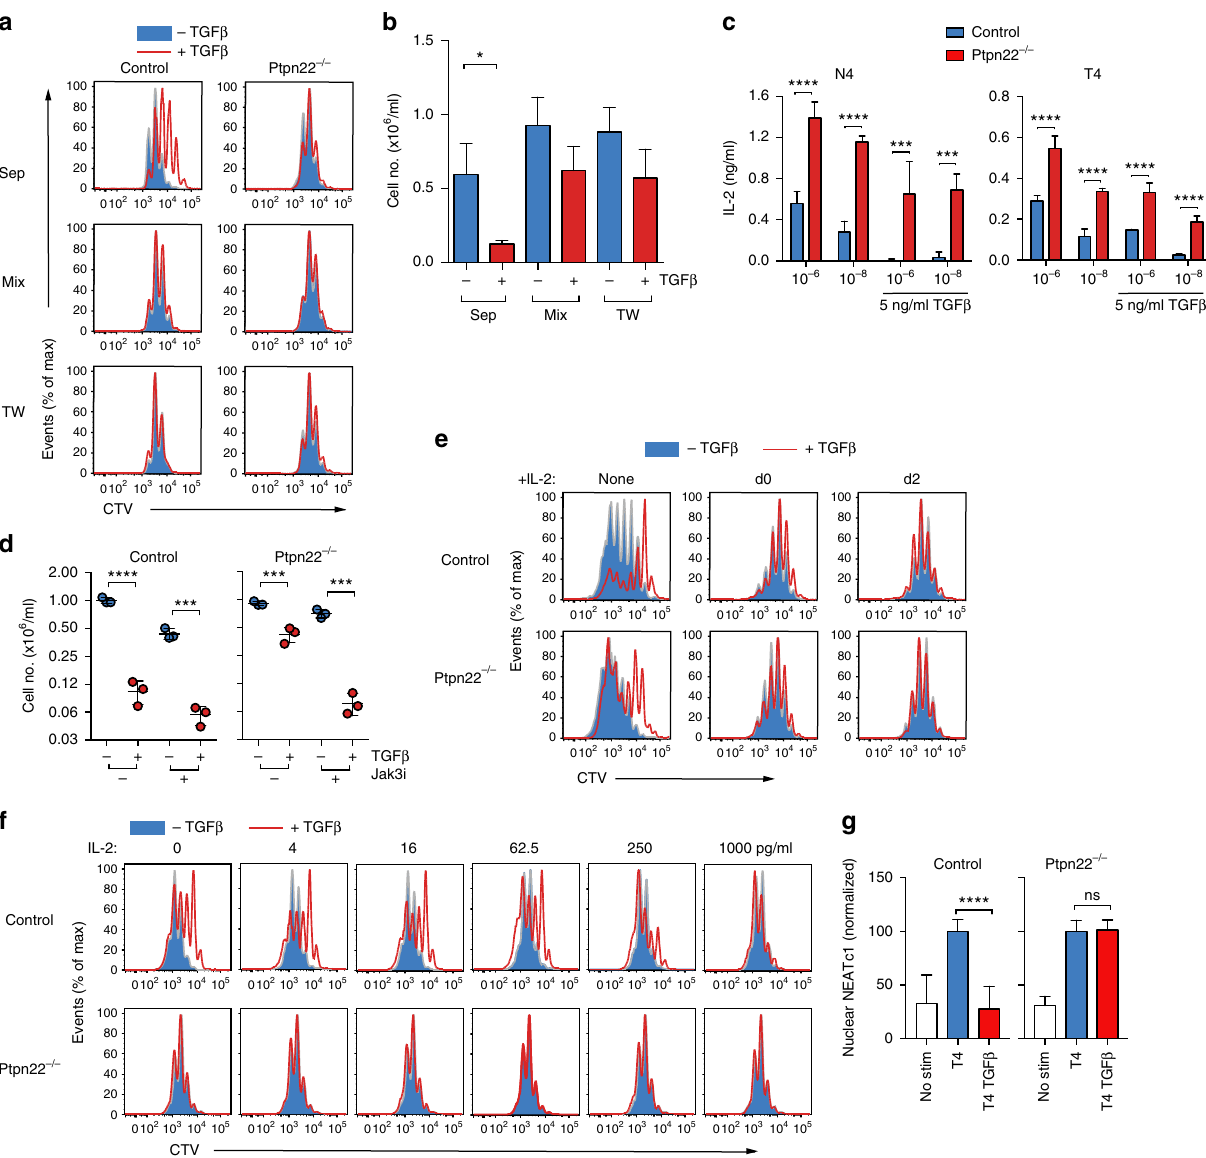
Fig. 5 Increased IL-2 production from Ptpn22 − / − OT-1 cells overcomes TGF β -mediated suppression. a Proliferation of CTV-labeled control and Ptpn22 − / − OT-1 cells stimulated with 10 − 8 M N4 for 3 days ± TGF β (5 ng/ml) cultured in separate wells, in the same well (mix) or in transwells. Representative histograms showing CTV dilution are shown. b Quanti fi cation of recovered control cells. Bars represent mean ± s.e.m. of six individual animals pooled from two separate experiments, * p < 0.05 as determined using Students t test. c IL-2 was quanti fi ed by ELISA in supernatants of control and Ptpn22 − / − OT-1 cells stimulated for 24 h with N4 or T4 (10 − 6 , 10 − 8 M) in the presence of anti-CD25 Ab (10 μ g/ml) TGF β (5 ng/ml). Bars represent triplicate values from groups of three animals, error bar represents s.d. d Jak3 signaling is required to overcome TGF β -mediated suppression. Control and Ptpn22 − / − OT-1 cells stimulated with N4 (10 − 6 M) ± TGF β (5 ng/ml) were cultured for 3d with or without JAK3 inhibitor added for the last 24 h of culture. Live cell recovery is shown, dots represent triplicate values of pooled mice, line represents mean and error bars s.d. e Supplementation with IL-2 as late as d2 of culture can override TGF β -mediated suppression. Control and Ptpn22 − / − OT-1 cells stimulated with T4 peptide (10 − 6 M) for 3d, ± TGF β (5 ng/ml) and ± IL-2 (1 ng/ml) added on d0 or d2. Representative histograms of CTV dilution are shown. f Reversal of TGF β -mediated suppression by titrating IL-2. Control and Ptpn22 − / − OT-1 cells stimulated with N4 (10 − 6 M) ± TGF β (5 ng/ml) were cultured for 3d either without or with the addition of exogenous IL-2 at varying concentrations (0 – 1000pg/ml). Representative histograms of CTV dilution are shown. Data c – f is representative of at least three experiments. *** p < 0.001 and **** p < 0.0001, as determined using two-way ANOVA with Tukey ’ s post test for multiple comparisons. g Ptpn22 − / − OT-1 cells are resistance to TGF β inhibition of NFATc1 translocation. Control and Ptpn22 − / − OT-1 cells stimulated with T4 (10 − 6 M) ± TGF β for 4 h were lysed and nuclear extracts analysed for NFATc1 expression. Data are pooled and normalized from three separate experiments. Error bars represent s.e.m. and **** p < 0.0001,